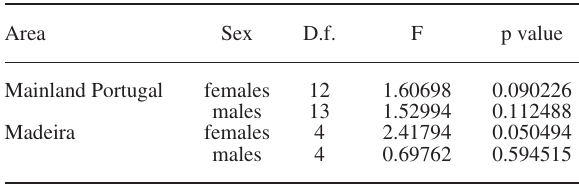
Table 5. – Results of the comparison of the age-length keys of dif- ferent time series in mainland Portugal and